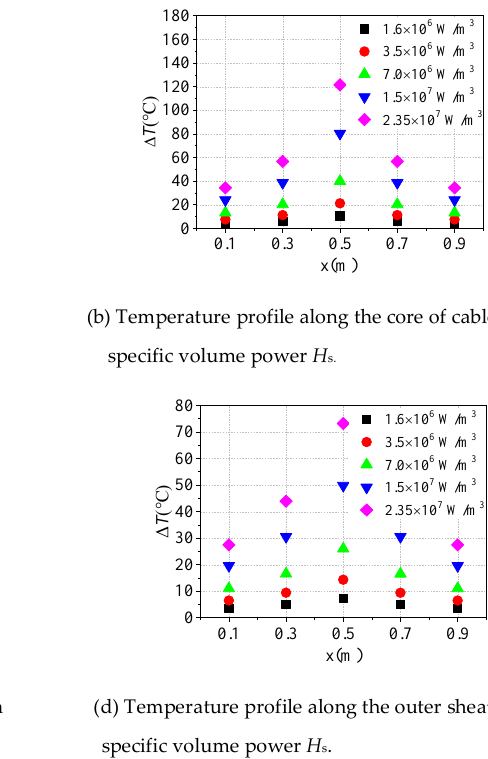
Figure 5. The temperature rise of the cable under poor